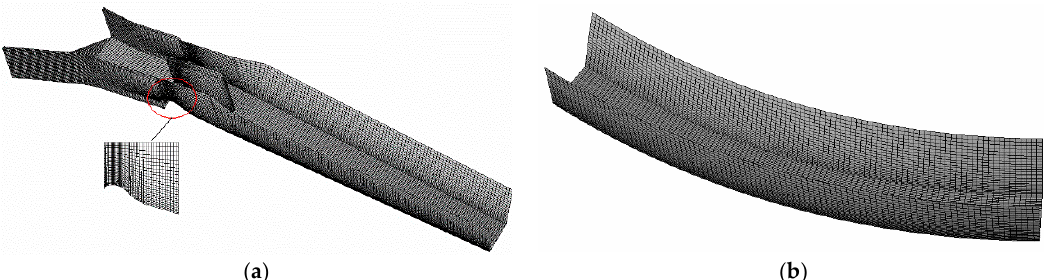
Figure 8. Schematic of the grid: ( a ) in the weir crest; and ( b ) in the curved section of the smooth spillway. The vertical velocity at position [x = 1.4, y = 0, z = − 0.3] of the smooth spillway for three distances